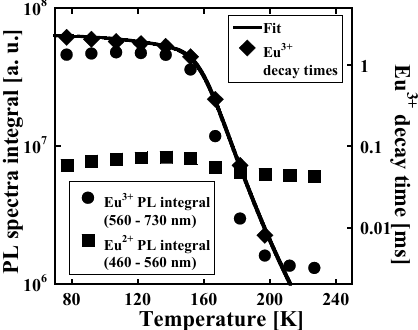
Figure 9. Temperature dependence of PL spectra integrals, separately for Eu 3+ (560–730 nm) and Eu 2+ (460–560 nm) emission region (see Figure 9) under 390 nm excitation and Eu 3+ decay times ( λ ex = 390 nm, λ em = 592 nm) with fit by the phenomenological model (see Equation (4)) of KLuS 2 :Eu (0.05%).